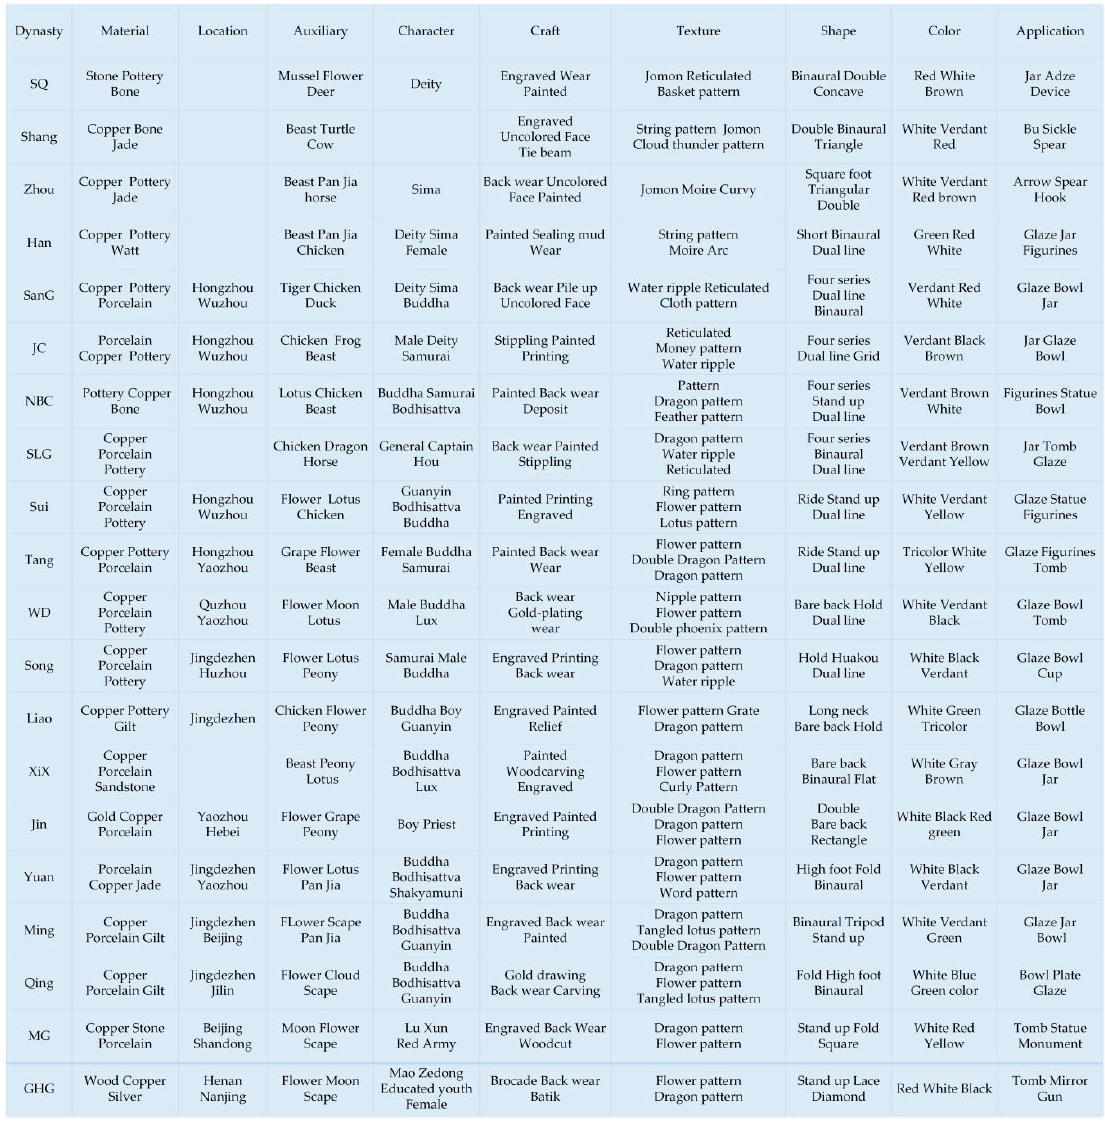
Figure 7. Prevalence meme labels in all dynasties.